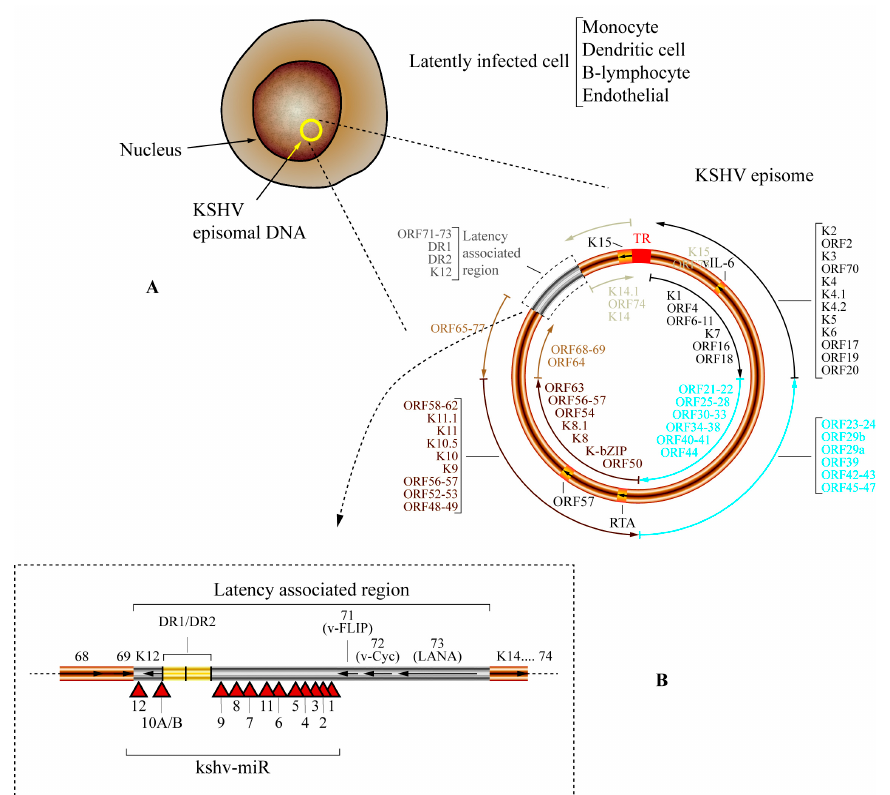
Figure 4. Genome organization and location of miRNA encoded by Kaposi’s sarcoma-associated herpesvirus (KSHV) (HHV-8). ( A ) After primary infection, KSHV establishes a latent infection in monocytes, dendritic cells, B-lymphocytes, and endothelial cells. During latency, the KSHV genome is maintained as a circular episome (represented as a yellow circle inside the nucleus). The general structure of episomal DNA is presented, and the relative positions of the open reading frames (ORFs) are shown. The grey box represents the latency-associated region. The terminal repeat (TR) region is represented by a red box, and the ORFs encoding for viral interleukin 6 (vIL-6), the replication and transcription activator (RTA), ORF57, and K15 are represented by light orange boxes. The outer circular arrows refer to the ORFs that are transcribed in antisense orientation, while the inner circular arrows refer to those that are transcribed in the opposite orientation. To facilitate the representation of the different ORFs and their relative location, and the outer and inner circular arrows are presented in different colors (black, light blue, brown, light brown and light grey); ( B ) Genomic location of miRNAs encoded by KSHV (kshv-miR). A linear representation of the latency-associated region (grey box) of the KSHV genome is shown, and the locations of miRNA precursors are denoted by red triangles. The positions of ORFs 68, 69, K12, 71 (v-FLIP), 72 (v-Cyc), 73 (LANA), K14, and 74 are also shown; arrows inside each ORF indicate the direction of transcription. The two adjacent yellow boxes represent the DR1/DR2